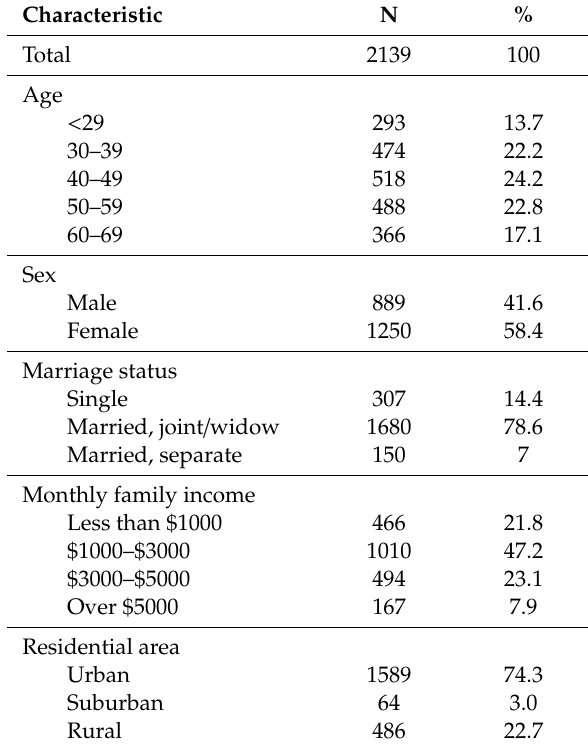
Table 1. Demographic characteristics of the target population participating in this